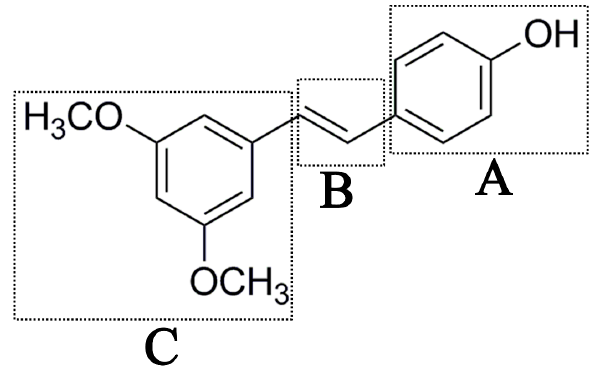
Figure 1. Chemical structures of PTE and three partitions of PTE.